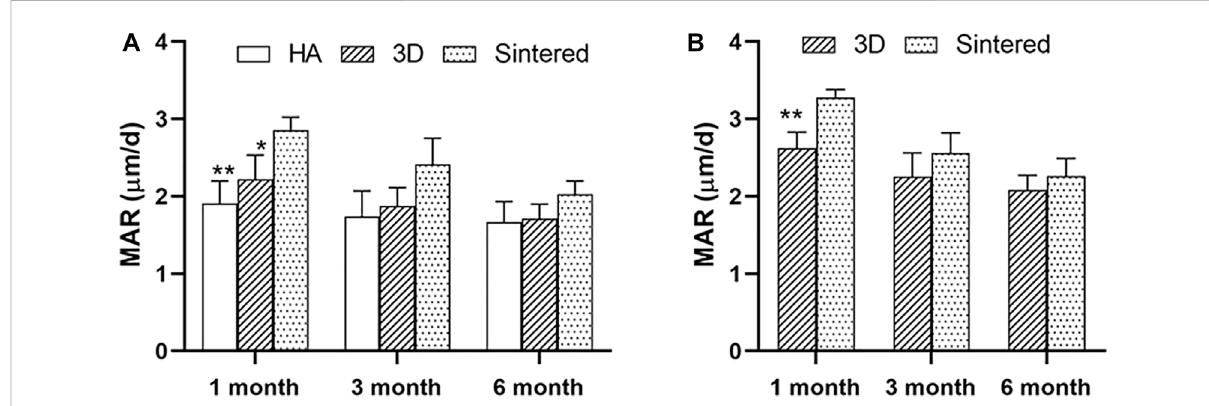
FIGURE 8 ComparisonofMARvaluesaroundprosthesisandMARvaluesinprosthesiswithdifferentmaterials. (A) TheMARvaluesaroundtheprosthesisof three materials at different times. * indicates that MAR values of thesintered group and 3Dgroup were signi fi cantly different at 1 month, p < 0.05; **, indicatesthatMARvaluesofsinteredgroupandHAgroupweresigni fi cantlydifferentat1month,p < 0.01. (B) MARvaluesinprosthesisoftwoporous materials atdifferent times.*, indicates that theMAR values ofthe sintered group and 3Dgroup weresigni fi cantly different at1 month, p <